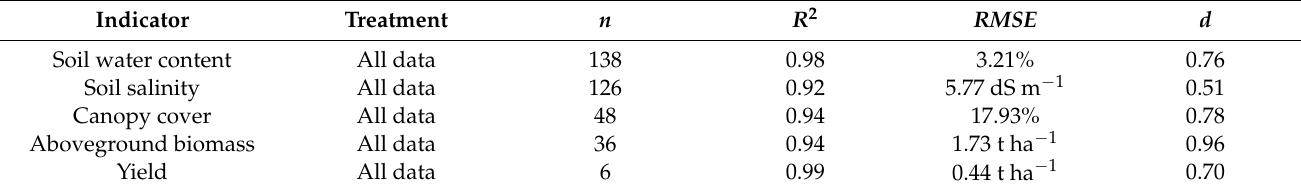
Table 3. Calibration of the AquaCrop model with the data set in the 2020 cotton season.